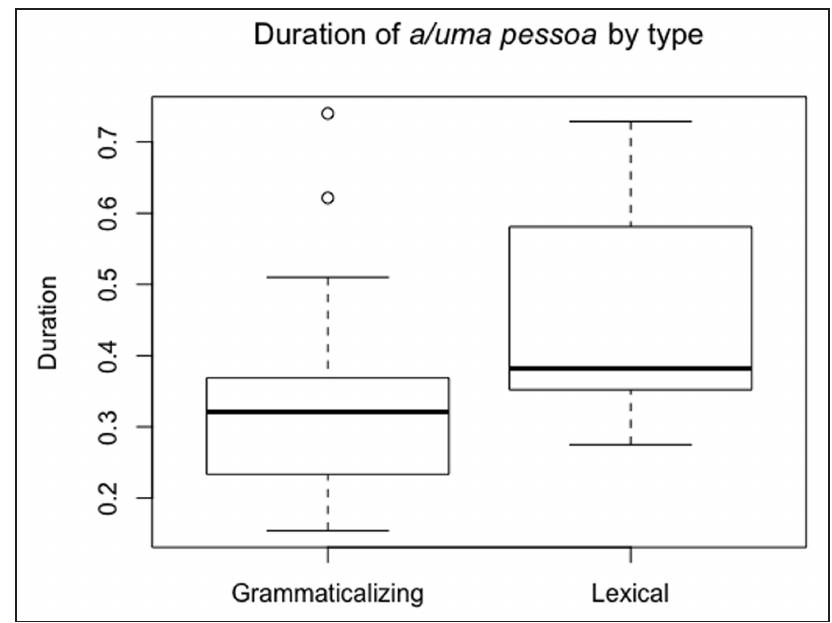
Figure 1: Duration of the sequence a/uma pessoa in potentially grammaticalized vs. lexical signs of phonetic attrition. Thus, I measured the duration of the sequences a/uma pessoa occurring without adjectival or relative clause modifiers using Praat and calculated their mean length, as shown in Figure 1 . The Wilcoxon rank sum test with continuity correction applied to the data shows that the difference in the duration of the potentially grammaticalizing occurrences and the lexical occurrences of a/uma pessoa is statistically significant ( W = 449, p = 0.001854).